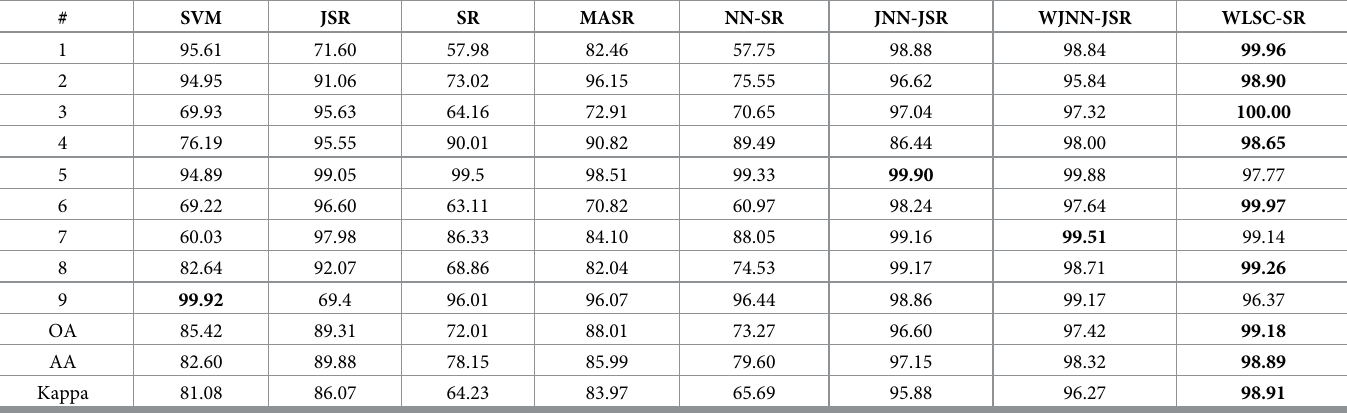
Table 3. Classification accuracy (in percent) of the Pavia University in the SVM [1], JSR [17], SR [16], MASR [19], NN-SR [18], JNN-JSR [27], WJNN-JSR [27], and WLSC-SR.